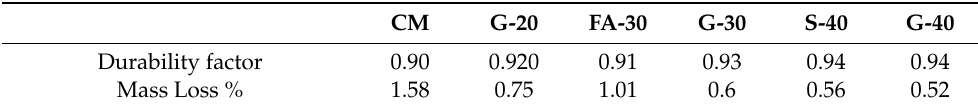
Figure 11. Relative dynamic modulus after freeze–thaw cycling. Table 5. Durability